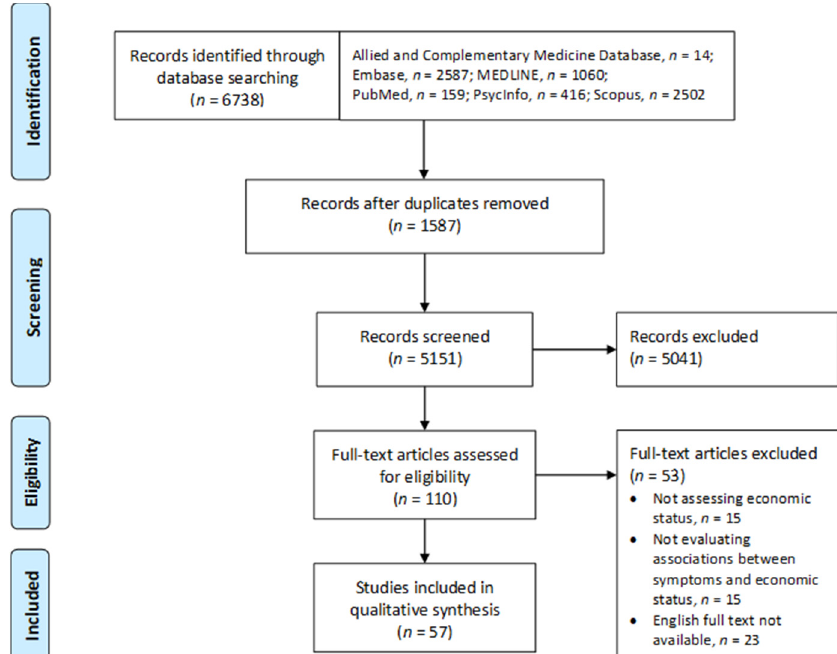
Figure 1. PRISMA flow diagram of study selection.